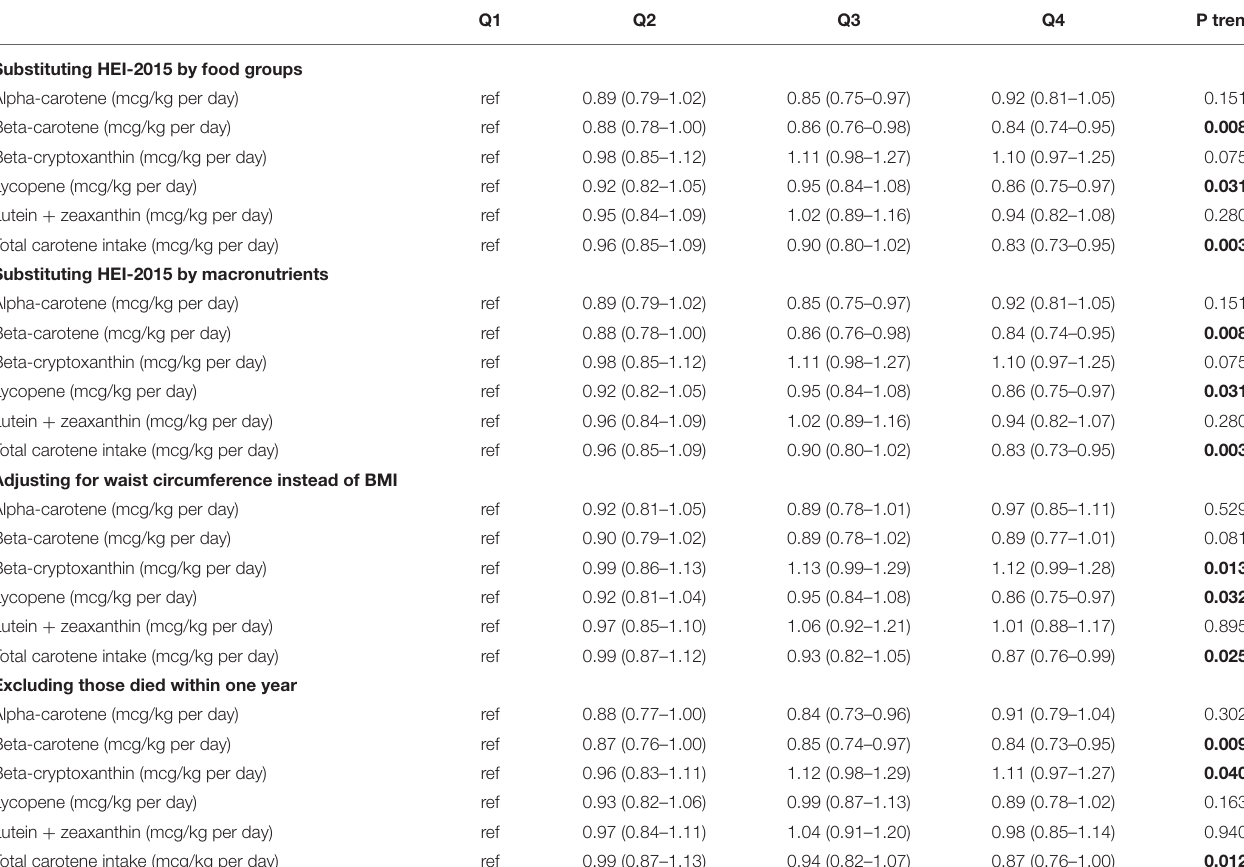
TABLE 3 | Results of sensitivity analyses of the associations between carotene intakes and mortality. Q1 Q2 Q3 Q4 P